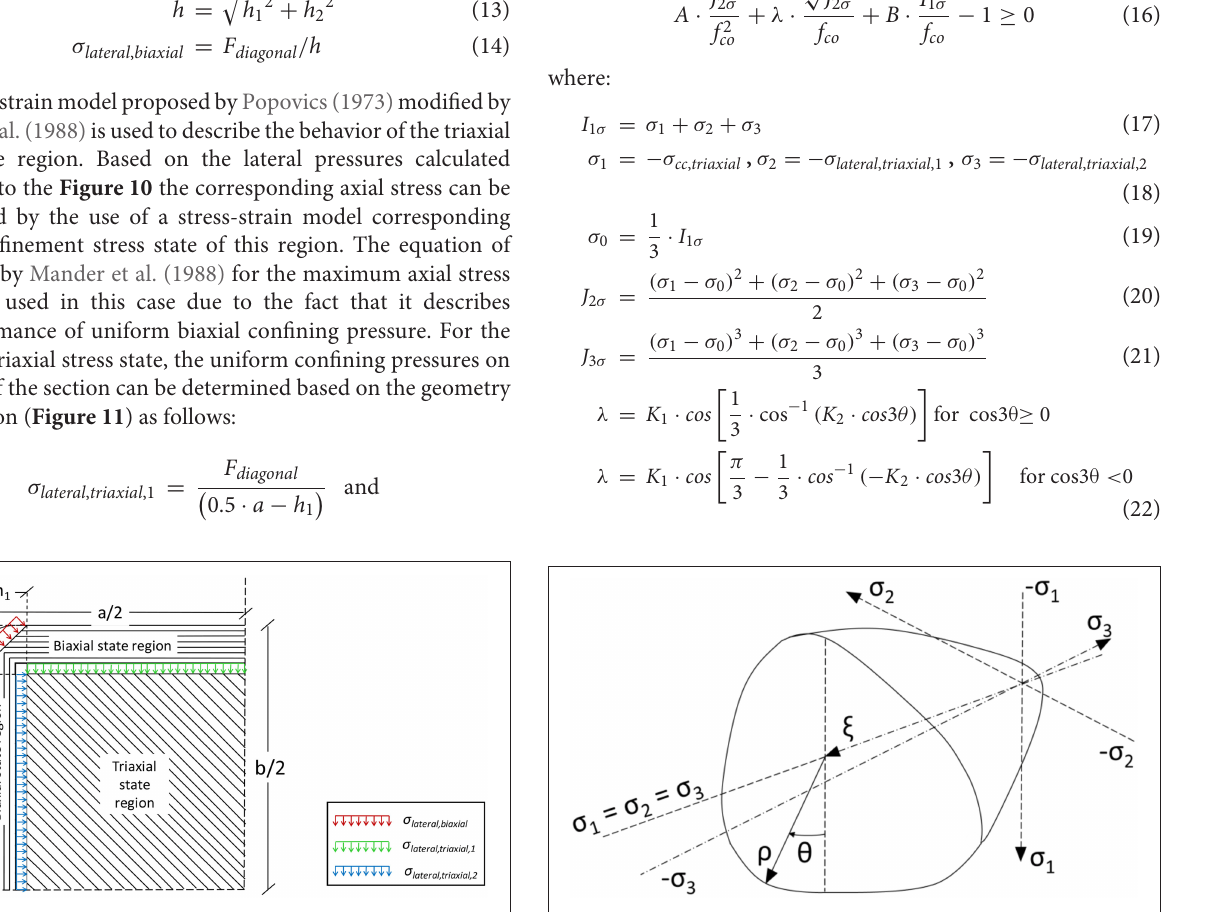
FIGURE 10 | Confining pressures in the different regions. FIGURE 11 | Ultimate strength surface by Ottosen